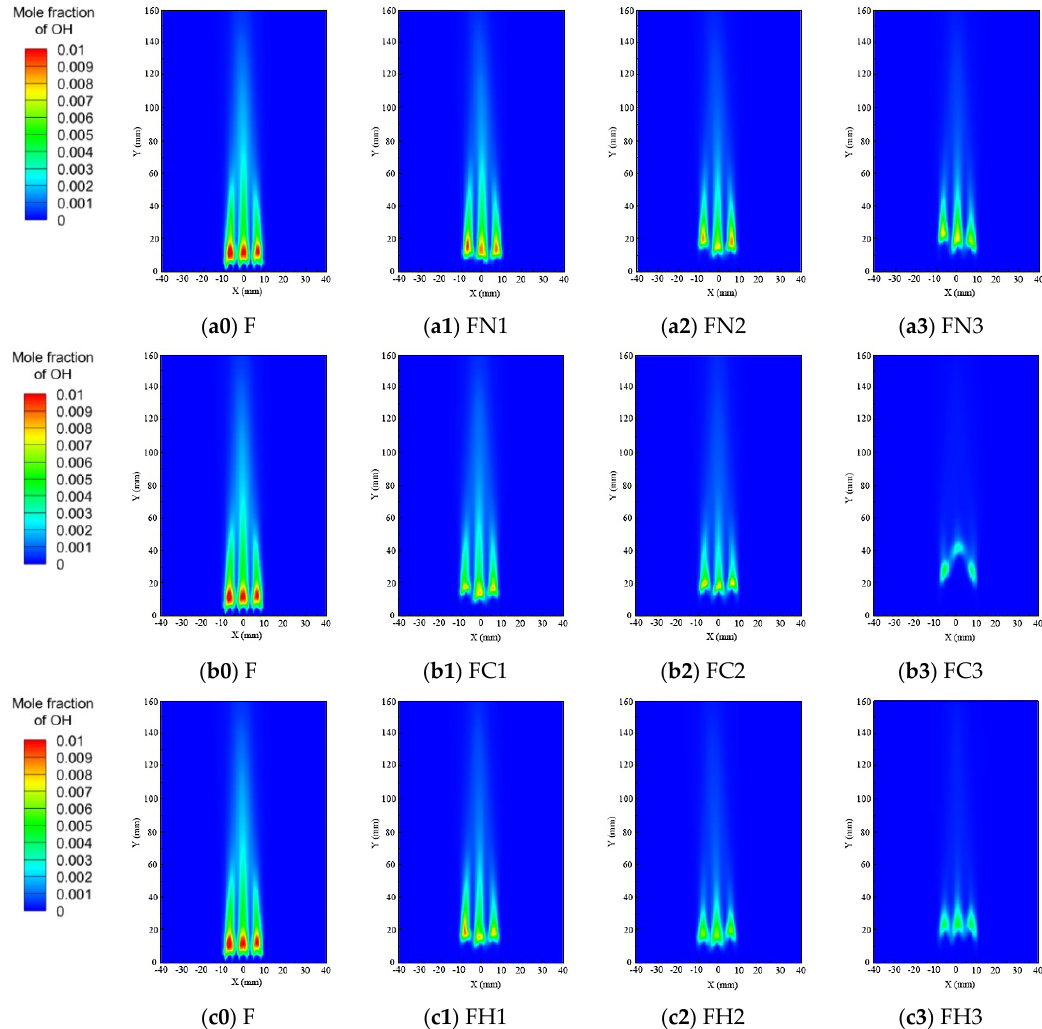
Figure 6. Concentration of the OH radicals in different diluted flames.